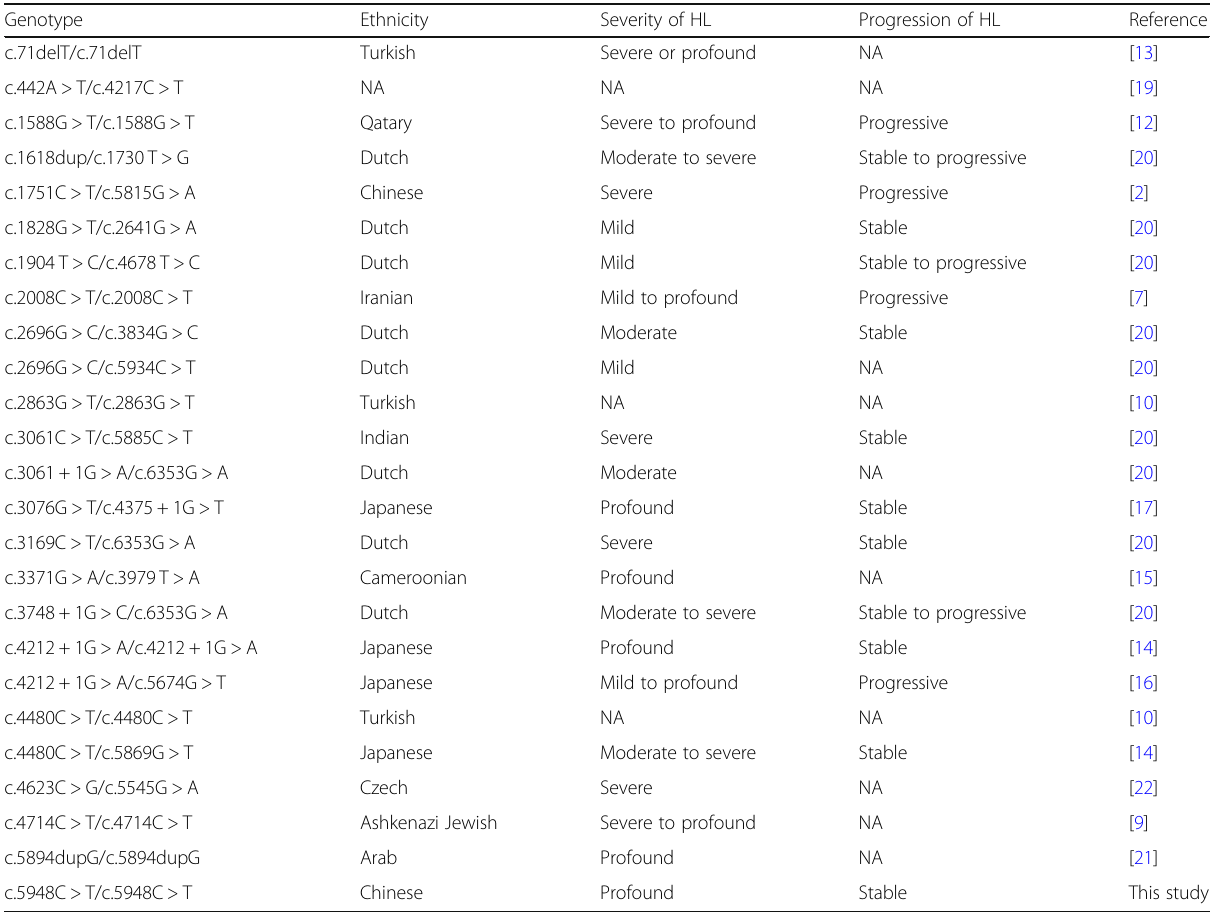
Table 1 Genotype-phenotype correlation of DFNB77 confirmed by segregation analysis